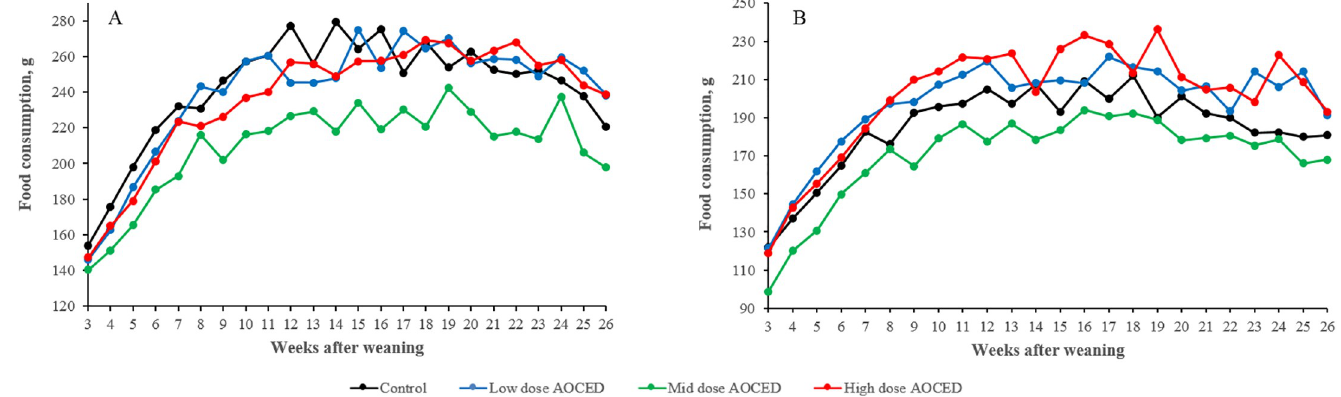
Fig 4. Food consumption of puppies (A—males; B—females) after weaning. Values are shown as group means (n = 5) in grams per dog per day. Statistically significant differences were observed between the mid-dose and control males on Weeks 7, 12, 14 and 18 (p < 0.1). Statistically significant differences were observed between the mid-dose and control females on Weeks 3 and 14 (p < 0.1), and between the high-dose and control groups on Weeks 15, 19, and 24 (p < 0.1).